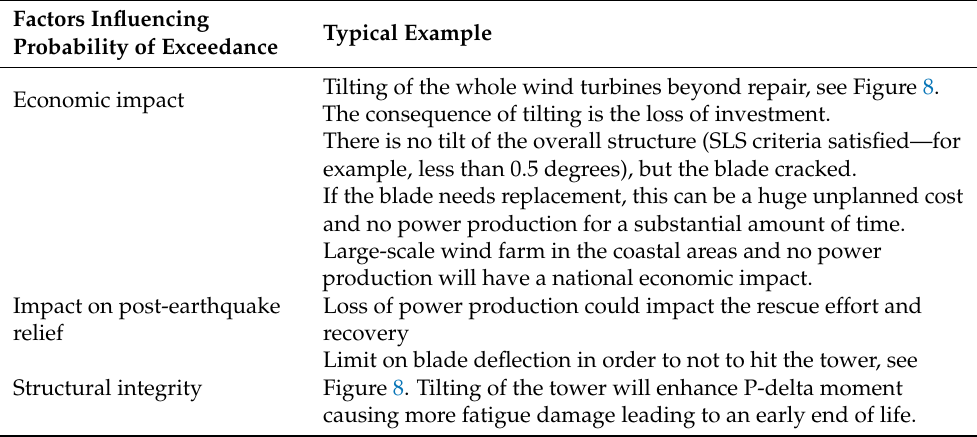
Table 2. Examples of offshore wind turbines with high consequences of failure where seismic design might need to be considered.